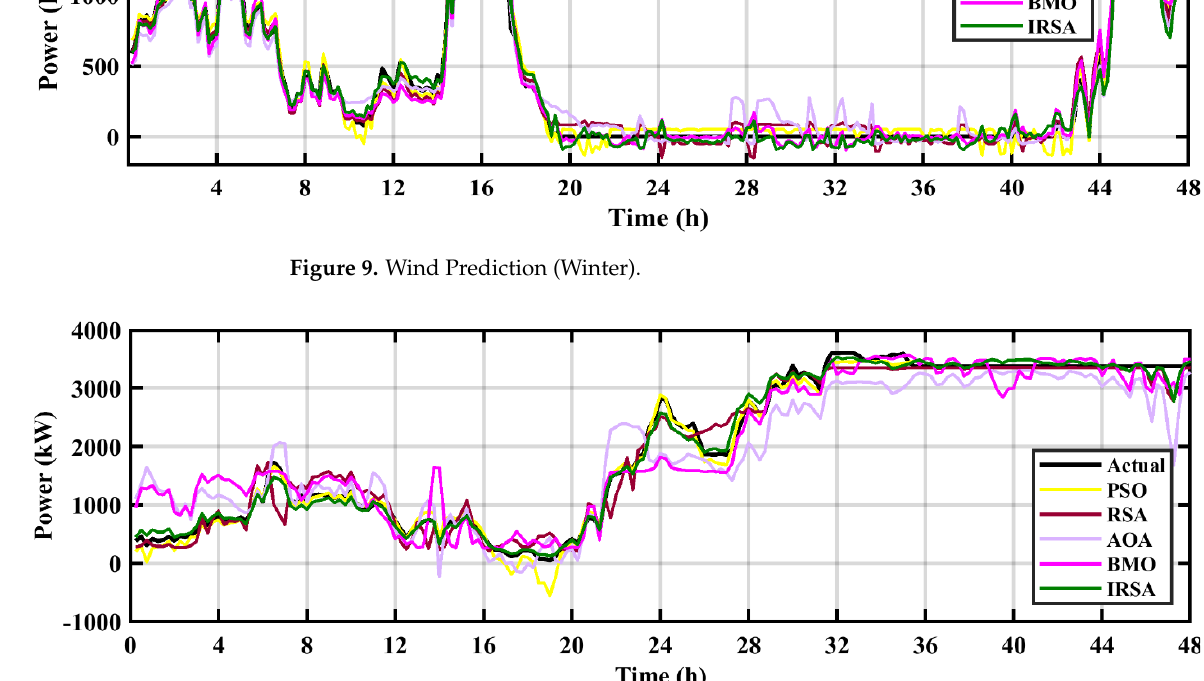
Figure 10. Wind Prediction (Summer)